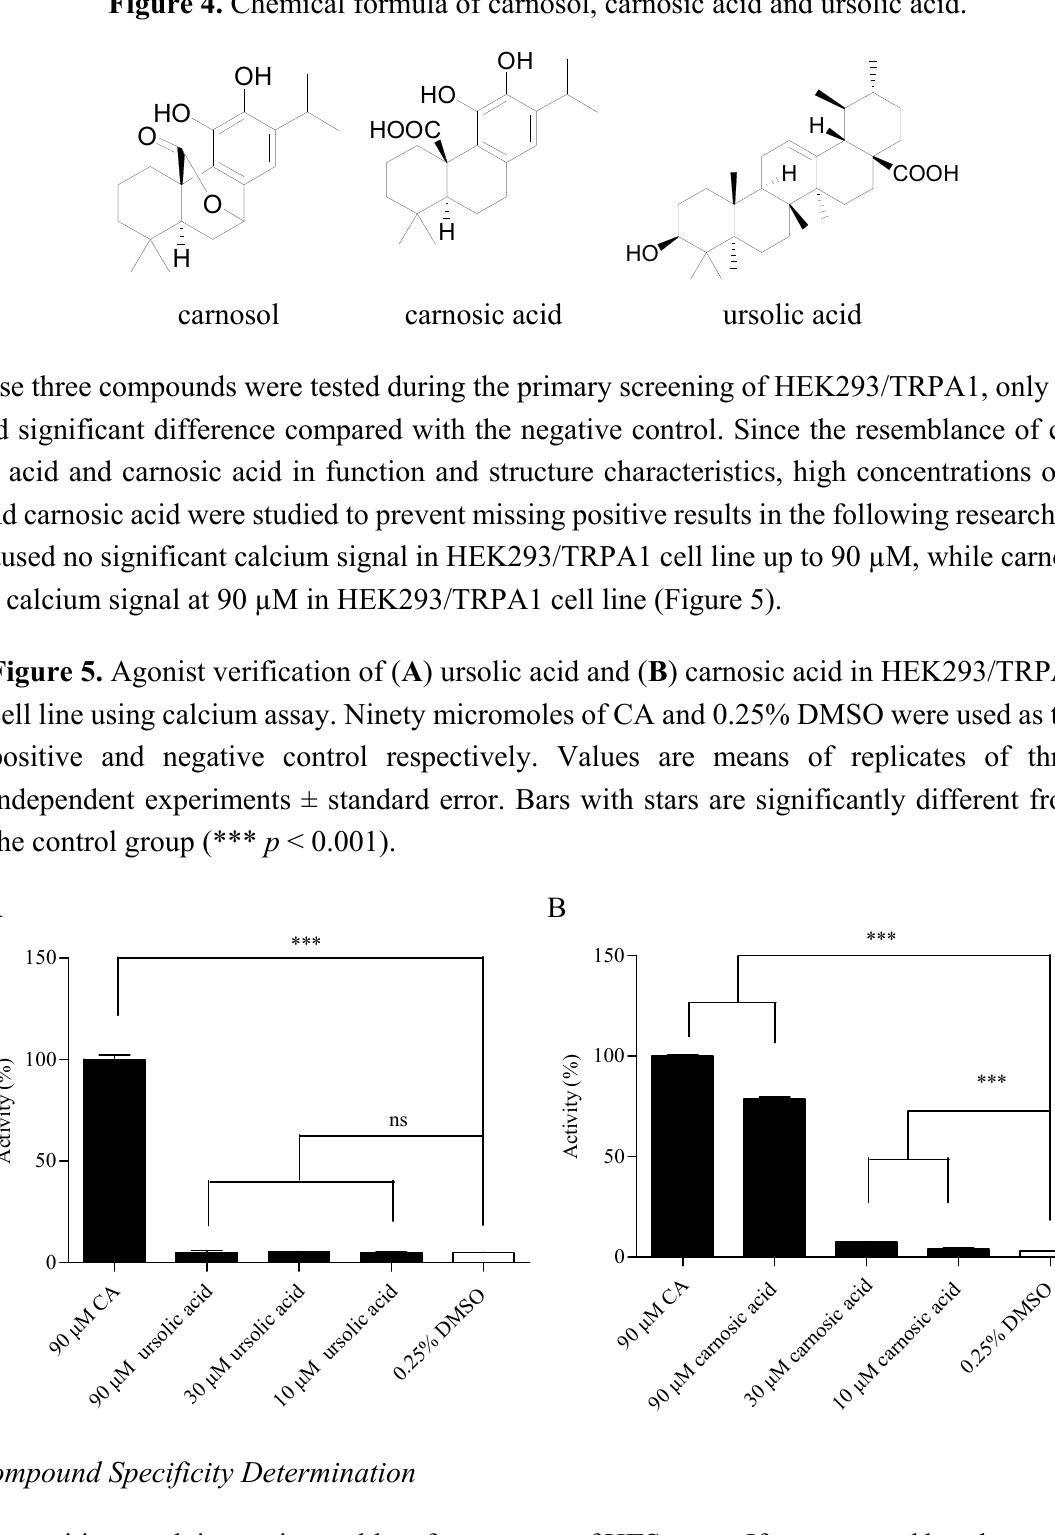
Figure 4. Chemical formula of carnosol, carnosic acid and ursolic